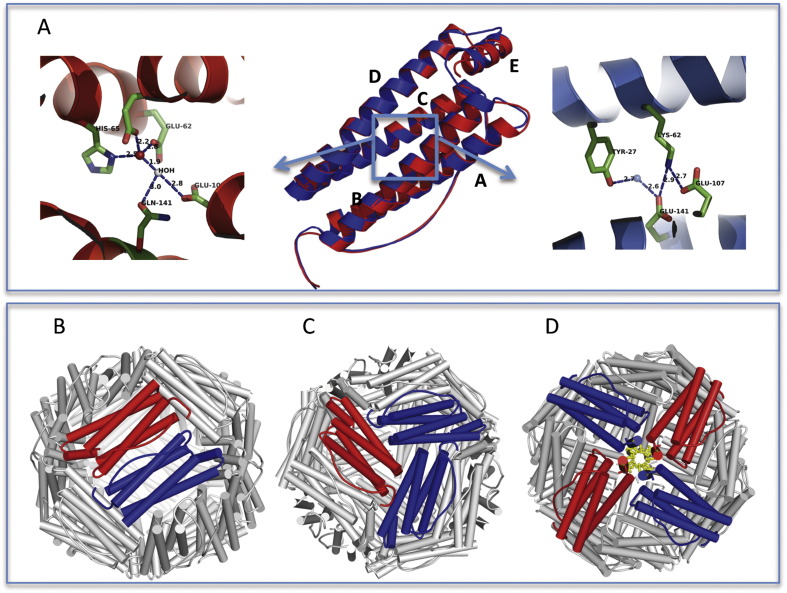
Three-dimensional structure of ferritin. Ferritin subunit is a four-helix bundle protein consisting of two couples of anti-parallel α-helices (A–B and C–D) connected by a long loop and a short C-terminal α-helix (E) important for 24-mer stabilization. Human L and H ferritin subunits share a 55% sequence identity and a remarkably similar 3D structure. A In central panel is shown a ribbon representation of superposed L (blue) and H (red) human ferritin subunits. Superposition of the two structures yielded a root mean square deviation (RMSD) of 0.5 Å, indicating an elevated level of structural similarity. The two subunits show a different residue arrangement in the center of four-helix bundle, corresponding to the blue box. Arrows departing from the box point to the expanded representation of the region in H-chain (panel left side) and L-chain (panel right side). In H chain, a ferroxidase center is formed by a set of iron coordinating residues, which are replaced by a salt bridge forming amino acids in the L chain. The functional protein is a 24-mer polymer made of variable proportion of H and L chains that assemble following a two-three- and four-fold symmetry. The assembled ferritin appears as a hollow spherical shell (panel B). Subunit interactions in the 24-mer generate 12 dimeric interfaces (a dimer formed by one H and one L chain is shown as an example in panel B), eight hydrophilic channels, each obtained from 3 subunits, at the three fold axes (panel C) and six hydrophobic channels, obtained from 4 subunits at the four-fold axes (panel D). Structures were obtained from Protein Data Bank (PDB code: 2FFX for L- chain, 1FHA for H-chain; Berman et al, 2000).